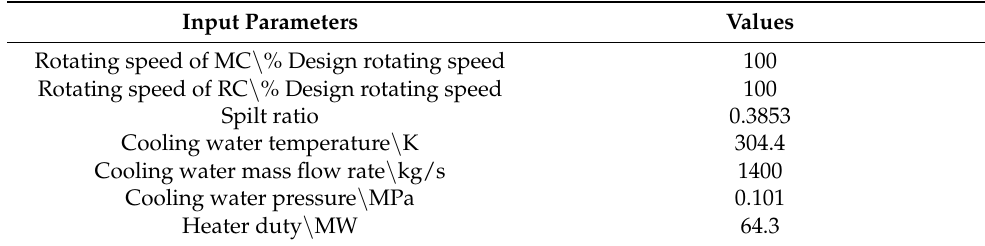
Table 5. Input parameters under the design condition of the recompression cycle model.